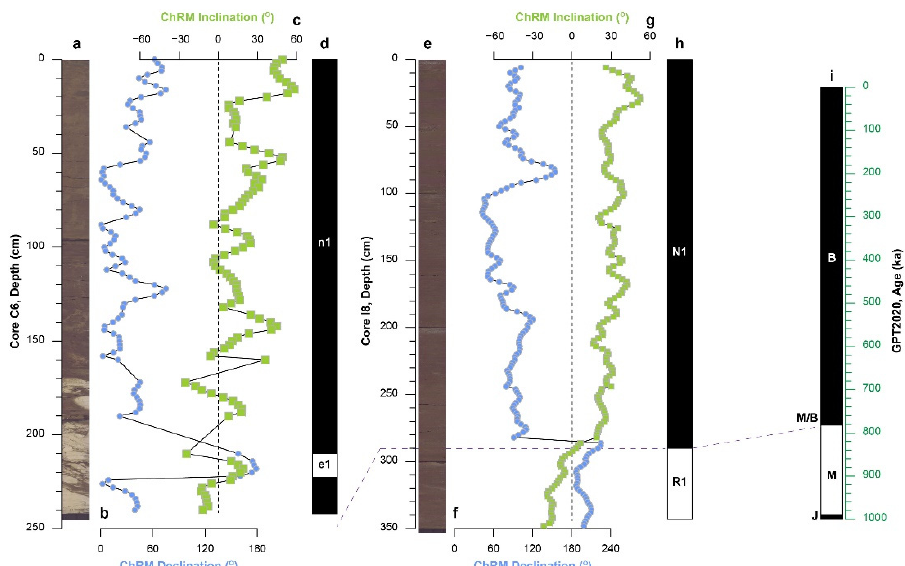
Figure 2. Magnetostratigraphy of cores C6 and I8. ( a ) Photo of core C6; ( b , c ) ChRM declination and inclination of core C6, respectively; ( d ) polarity of core C6; ( e ) photo of core I8; ( f , g ) ChRM declination and inclination of core I8, respectively; ( h ) polarity of core I8; ( i ) geological polarity timescale (GPT2020) [31]. B, Brunhes chron; M, Matuyama chron; J, Jaramillo subchron; M/B, the Matuyama/Brunhes boundary (0.773 ka).